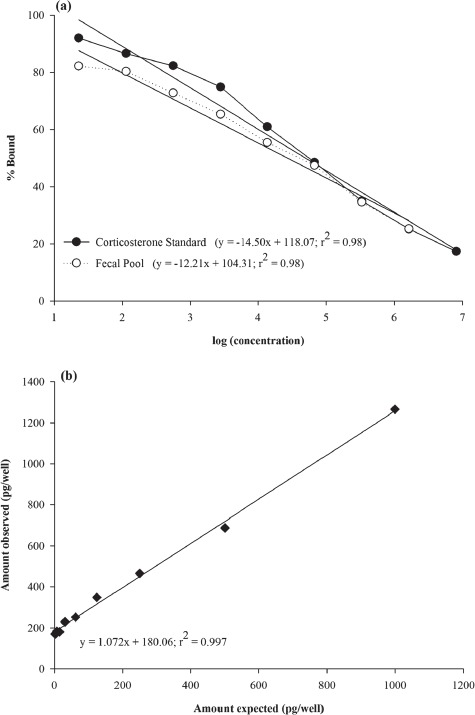
(a) Parallelism results for corticosterone in Necturus beyeri fecal samples; serial dilutions of pooled fecal extracts (open circles) are parallel to the standard (black circles) curve. Linear regression equations are given at the bottom. (b) Accuracy results for corticosterone in N. beyeri fecal extracts. Pooled feces spiked with known amounts of corticosterone showed good accuracy and little to no matrix effect. Regression equation given at bottom